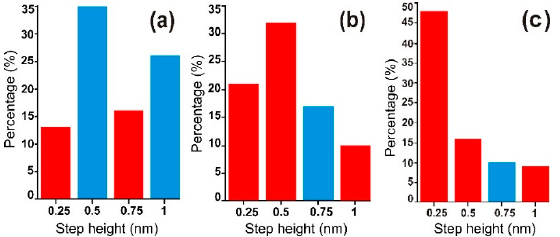
Figure 39. The respective histograms of the step height probability for the graphenized surfaces of: ( a ) 4H-SiC; ( b ) 6H-SiC; and ( c ) 3C-SiC substrates [22].